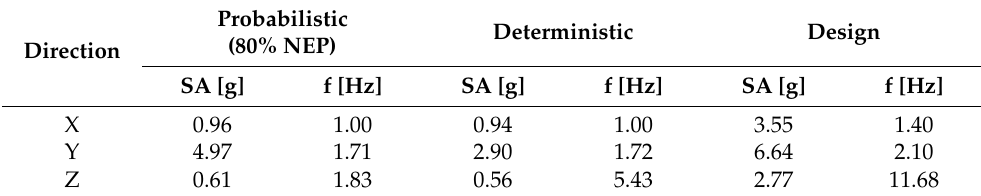
Table 4. Peak values of acceleration response spectrum.